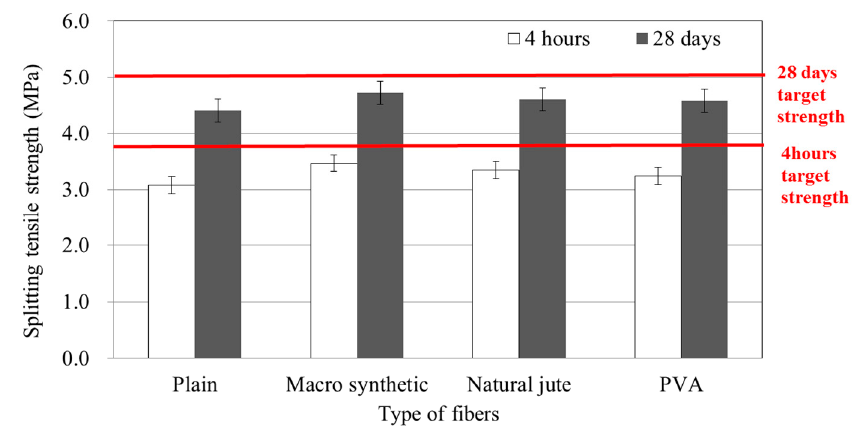
Figure 9. Splitting tensile strength of RCLMFRRHCC.